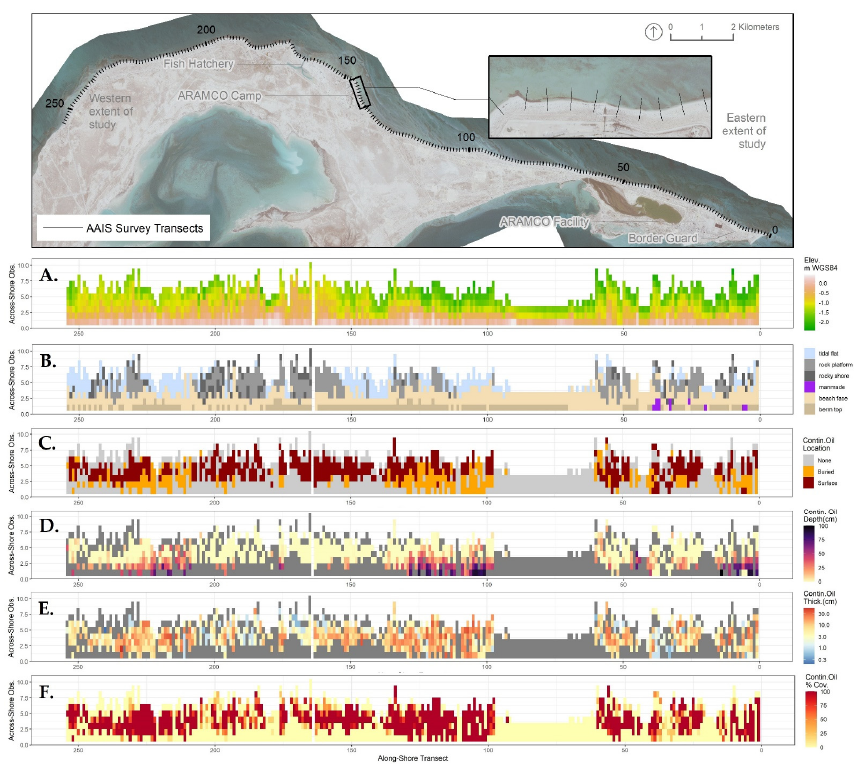
Figure 2. Across-shore tile charts depicting recorded elevation (m WGS84) ( A ), geomorphology descriptor ( B ), presence of buried or subsurface oil at each observation location ( C ), depth of burial of continuous pavements in cm ( D ), thickness of continuous pavements in cm ( E ), and percent cover of continuous pavements at each observation location ( F ). Each field observation was plotted as a single tile, oriented such that observations made along the same transect appeared as a vertical stack of tiles, with the most landward observation at the bottom and the most seaward observation at the top.